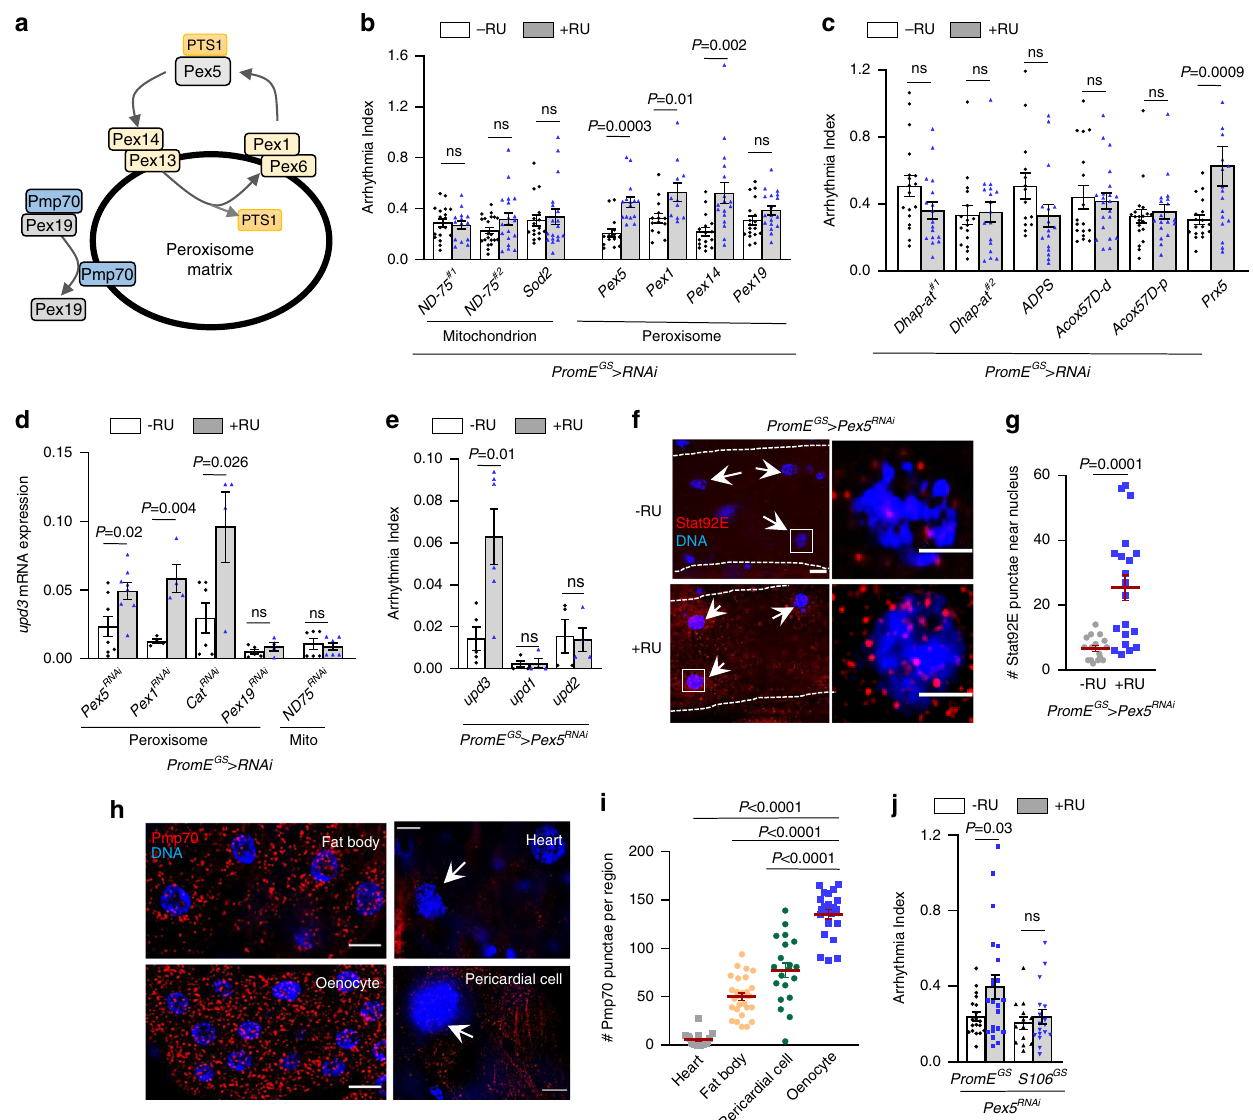
Fig. 4 Impaired peroxisomal import in oenocytes induces upd3 and promotes cardiac arrhythmia. a Schematic diagram showing the key genes involved in peroxisomal import and membrane assembly. b Arrhythmia index of oenocyte-speci fi c knockdown of mitochondrial complex I subunit ND-75 (two independent RNAi lines), mitochondrial Mn superoxide dismutase Sod2 , peroxisomal import factors ( Pex5, Pex1, Pex14 ), and peroxisomal membrane assembly factor ( Pex19 ), (n left-right = 14, 15, 14, 11, 16, 17, 18, 18 fl ies). Oenocyte-speci fi c GeneSwitch driver ( PromE GS - Gal4 ) was used. c Arrhythmia index of oenocyte-speci fi c knockdown of peroxisomal matrix enzymes, Dhap-at, ADPS, Acox57D-d, Acox57D-p, Prx5 (n left-right = 17, 18, 18, 18, 18, 17, 21, 20, 18, 16, 17, 14, 17 fl ies). d QRT-PCR analysis showing relative mRNA levels of upd3 from dissected oenocytes of Pex5, Pex1, Cat, Pex19 and ND-75 KD fl ies. Mito: Mitochondrion. N = 4 biological samples from 2 independent experiments. e QRT-PCR analysis showing relative mRNA levels of upd1, upd2, upd3 from dissected oenocytes of oenocyte-speci fi c Pex5 KD fl ies. N = 3 biological samples, from 2 independent experiments. f Representative images of Stat92E immunostaining of heart tissues dissected from fl ies with ( + RU) or without ( − RU) oenocyte-speci fi c Pex5 KD. Arrows indicate cardiomyocyte nuclei. White boxes indicate the regions shown in the right insets. Scale bar: 20 µ m (inset: 5 µ m). g Quanti fi cation on the number of Stat92E punctae around cardiomyocyte nuclei of oenocyte-speci fi c Pex5 KD fl ies (blue dots). Dot plot shows the quanti fi cations of 6 biological replicates, 3-4 selected regions of interest (ROIs) per replicate. h Representative images of Pmp70 immunostaining in fl y tissues. Arrows indicate cardiomyocyte and pericardial cell nuclei. Scale bar: 6.7 µ m. i Quanti fi cation of Pmp70-positive peroxisomes per region of interest. Dot plot shows the quanti fi cations of 6 biological replicates, 4 ROIs per replicate. j Arrhythmia of fl ies with Pex5 KD in either oenocytes ( PromE GS - Gal4 ) or fat body/gut ( S106GS-Gal4 ) (n left-right = 19, 22, 13, 17 fl ies). Data are represented as mean ± SEM. P values are calculated using two-sided unpaired t-test ( g ), one-way ANOVA followed ( i ), or two-way ANOVA ( b – e , j ) by Holm-Sidak multiple comparisons. ns: not signi fi reporter expression in young and aged oenocytes using PromE GS - To further con fi rm whether the YFP-PTS punctae are indeed Gal4 (with 1-day RU486 feeding). Consistent with the results localized with peroxisomes, we performed colocalization analysis from anti-SKL immunostaining, aged oenocytes showed less YFP- between YFP-PTS and peroxisome marker Pmp70. We found PTS punctae, which indicates that fewer YFP-PTS proteins were that the number of YFP-PTS punctae after normalized to imported into peroxisomes in aged fl ies (Fig. 6c). Pmp70 signals was signi fi cantly reduced in aged oenocytes